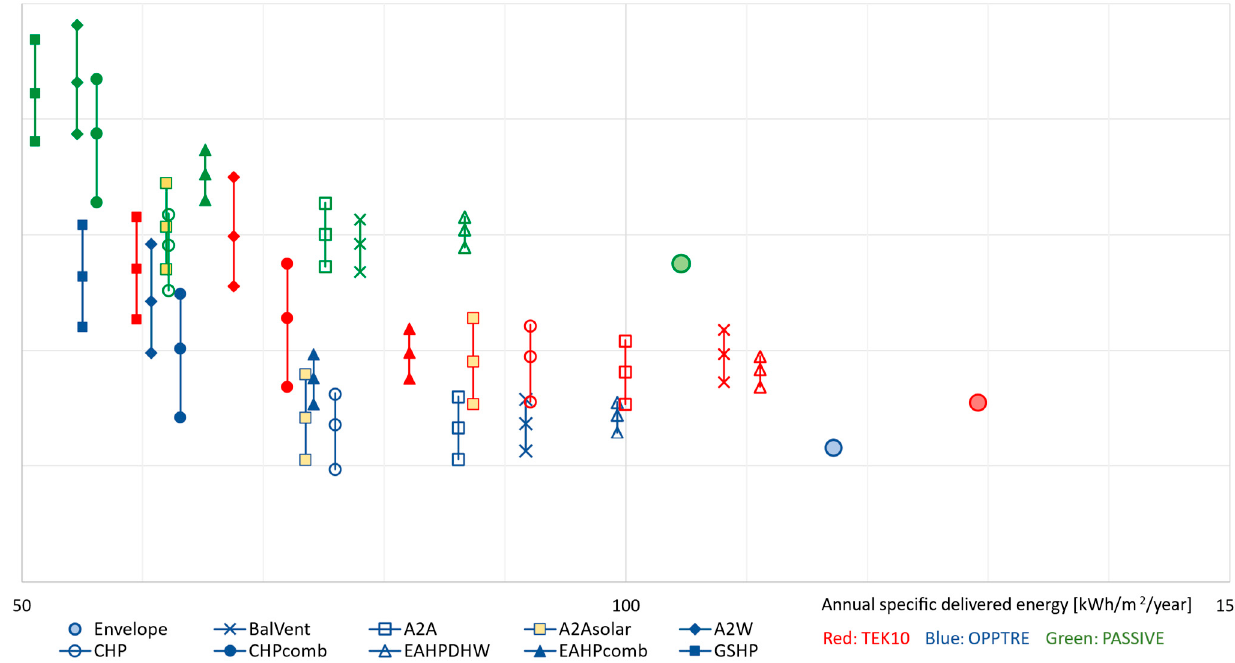
Figure 13. Specific global costs and delivered energy of the Kristiansand house with government grants included.